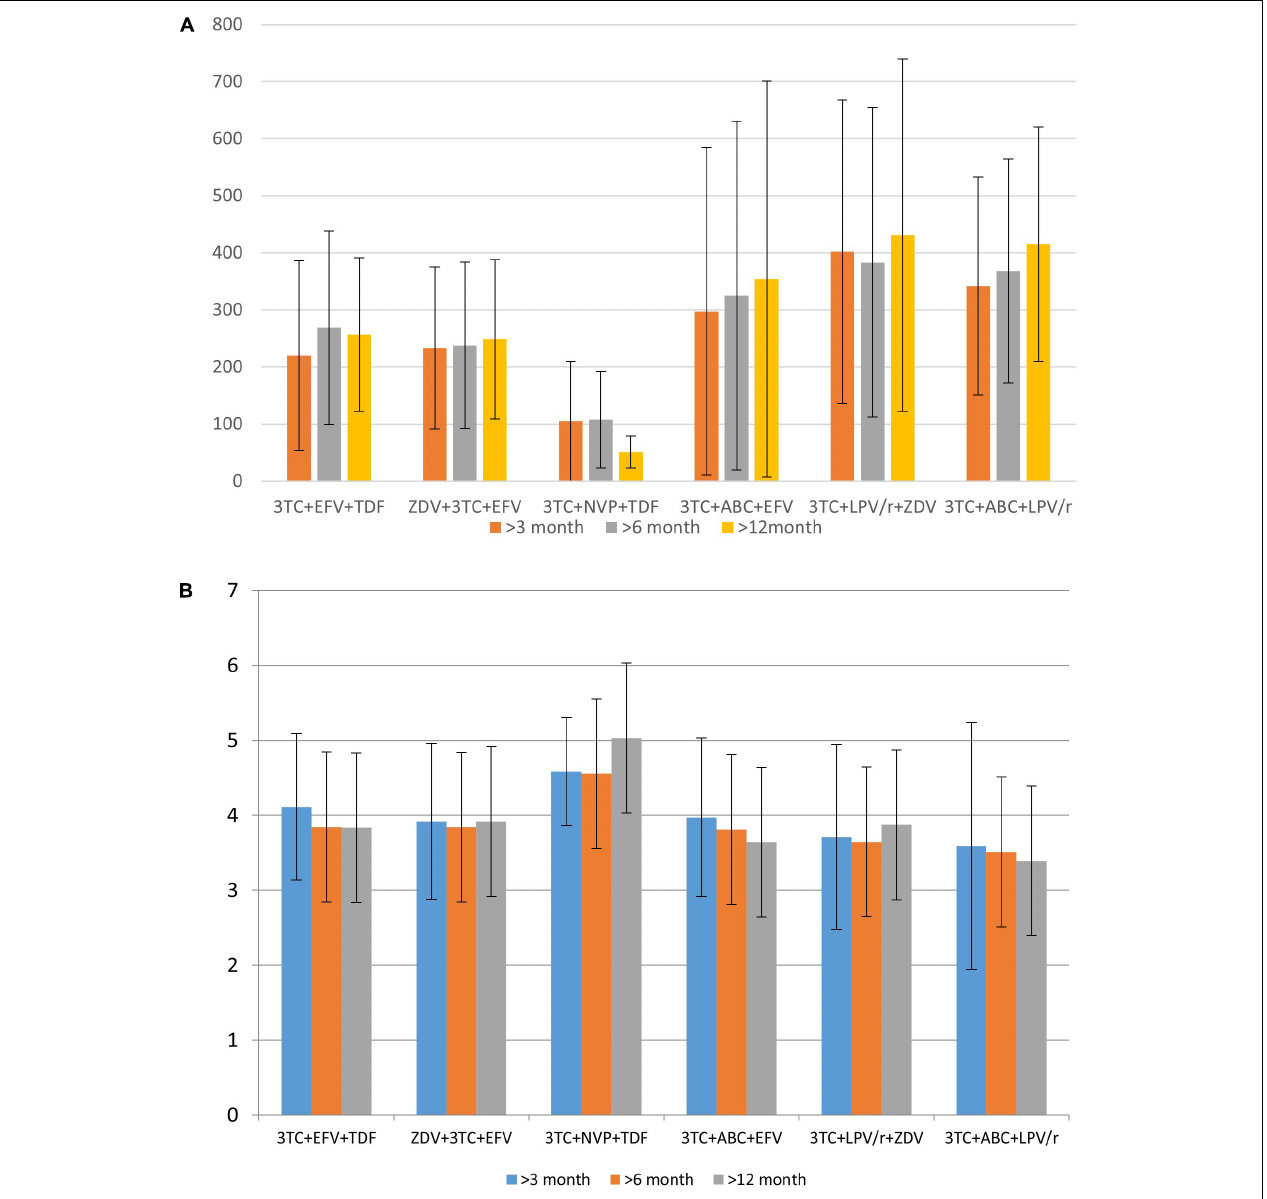
FIGURE 3 | The distribution of mean CD4+ cell count (A) and logarithmic values of viral load (B) for specific drug combination.